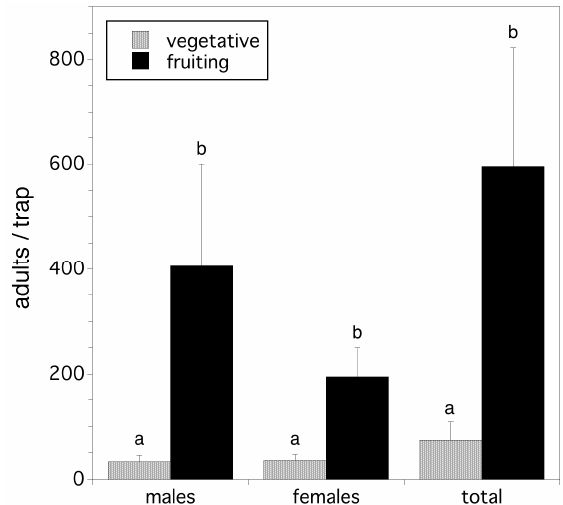
Figure 6. The effect of production system on the frequency (number) of insecticides used during the summer among the four management systems. Error bars are standard errors and the same letters associated with bars by treatment indicate that means are not significantly different from one another ( p > 0.05).